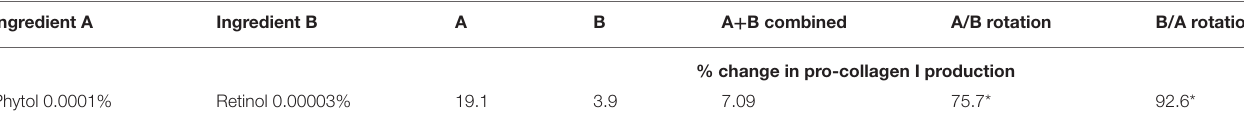
% change in pro-collagen I production